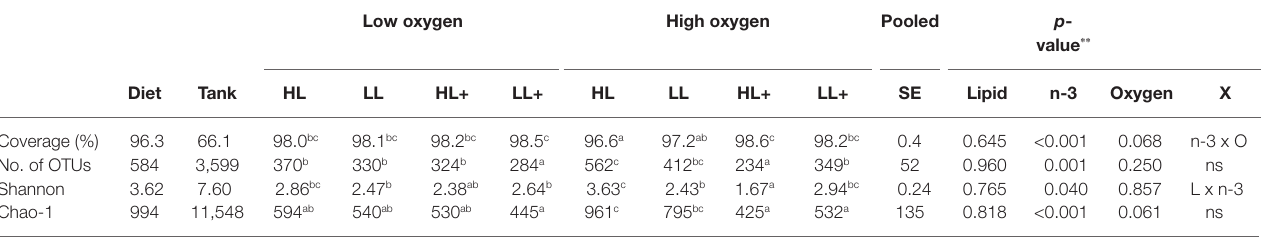
TABLE 2 | Alpha-diversity indices of diet, tank biofilm ( N = 3), and intestinal bacteria from Atlantic salmon ( N = 72) fed HL or LL with or without additional n-3 PUFA (+) for 116 days and reared at low and high oxygen. Low oxygen High oxygen Pooled p - value ** Diet Lipid n-3 Oxygen X